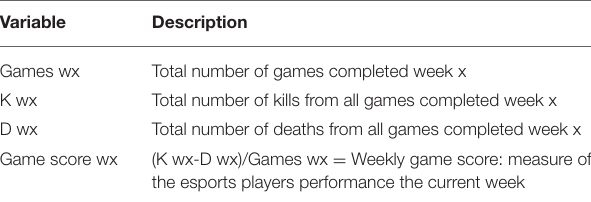
TABLE 2 | Variables detected from gaming statistics in CS: